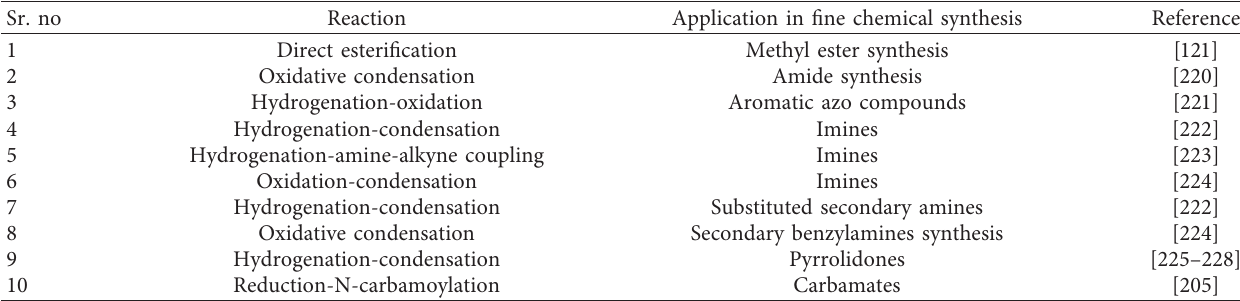
Table 10: Synthesis methods using gold as